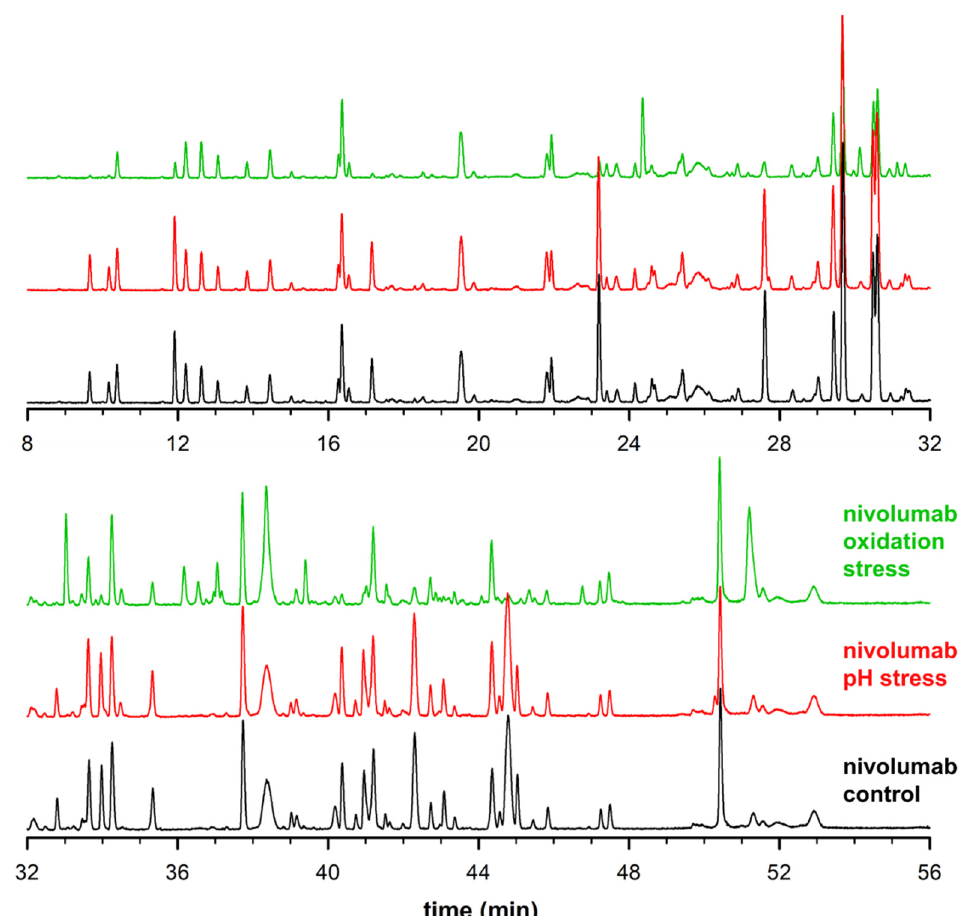
Figure 1. Total ion chromatograms (TICs) of control ( black ), high pH stress ( red ) and oxidative stress ( green ) samples (examples of chromatograms obtained in lab 2).